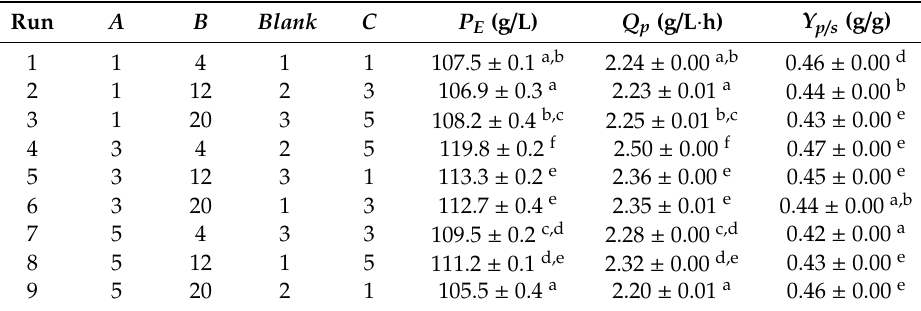
Table 1. The L 9 (3 4 ) orthogonal test and the experimental